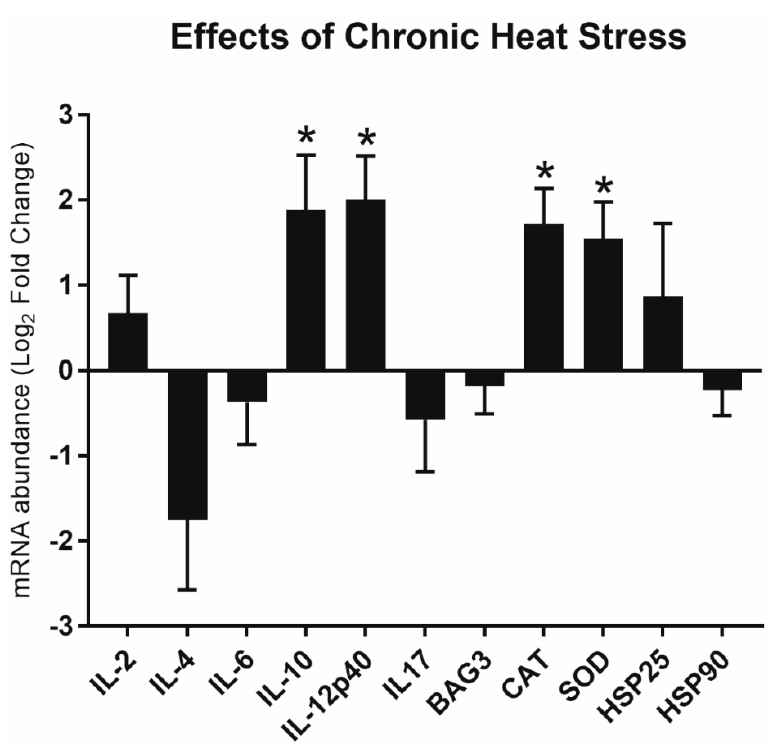
Figure 1. Relative messenger RNA (mRNA) expression of immune-related and stress-related genes in the spleens of slow-growing chickens that were challenged with chronic heat. Gene panel includes: interleukin: IL-2, IL-4. IL-6, IL-10, IL-12p40, and IL-17 and stress-related genes: CAT, SOD, BAG3, HSP25 and HSP90 . The x-axis shows a list of genes. The y-axis indicate the relative mRNA abundance of the genes after heat challenge (n = 8). Gene expression analysis was carried out with RT-qPCR. qPCR reactions were performed in triplicate. The geometric mean of the ACTB and UB reference genes was used to calculate delta cycle threshold (dCt) values. The relative gene expression (FC—fold change) was calculated with the delta delta cycle threshold (ddCt) formula and the fold change (FC) was calculated as follows: FC = 2 − ∆∆ Ct . FC values were transformed and presented as Log 2 FC. The standard error of the means (SEM) shows distribution of the Ct values. Normalized data (dCt values) of thermoneutral control (mock-injected) and heat-stressed control (mock-injected) groups were compared with a Student’s t-test. Significant differences ( p < 0.05) are labelled with an asterisk (*).